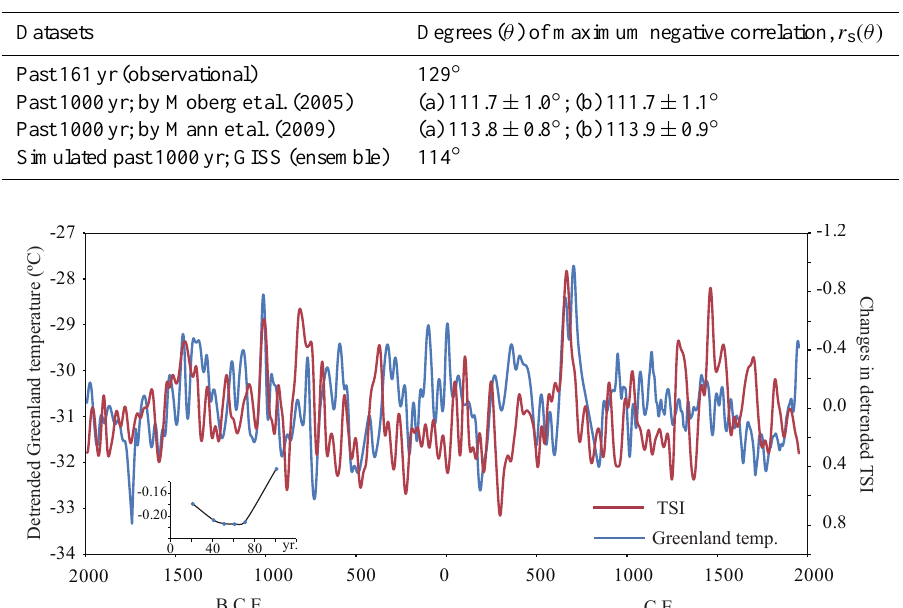
Table 2. Degrees ( θ ) of the maximum negative correlation coefficients, r s (θ) , in various settings. The 95% confidence intervals (2 σ ) are shown for the past 800yr with the ˆ T NH from Moberg et al. (2005) and Mann et al. (2009), including uncertainties in Greenland temperature and the NH temperature. For the past 800yr, two sets of solar forcing were used: (a) the dataset from Bard (Bard et al., 2000) and Crowley (Crowley, 2000) spliced into that of Lean et al. (Lean et al., 1995), and (b) the dataset from Delaygue and Bard (Delaygue and Bard, 2009) spliced into that of Wang et al. (Wang et al., 2005), as shown in Fig. 3.